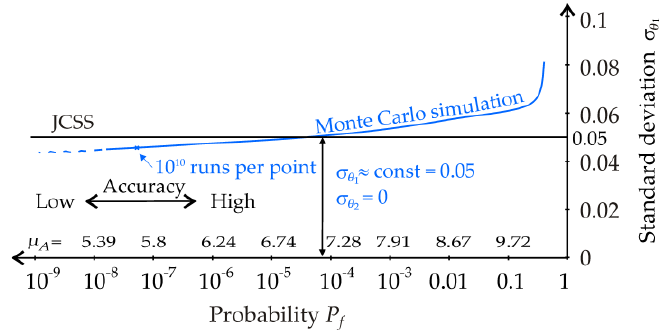
Figure 8. Course of the standard deviation of model uncertainty compared to [27] — case study 2. Other ways of introducing model uncertainties have been explored and are possible.